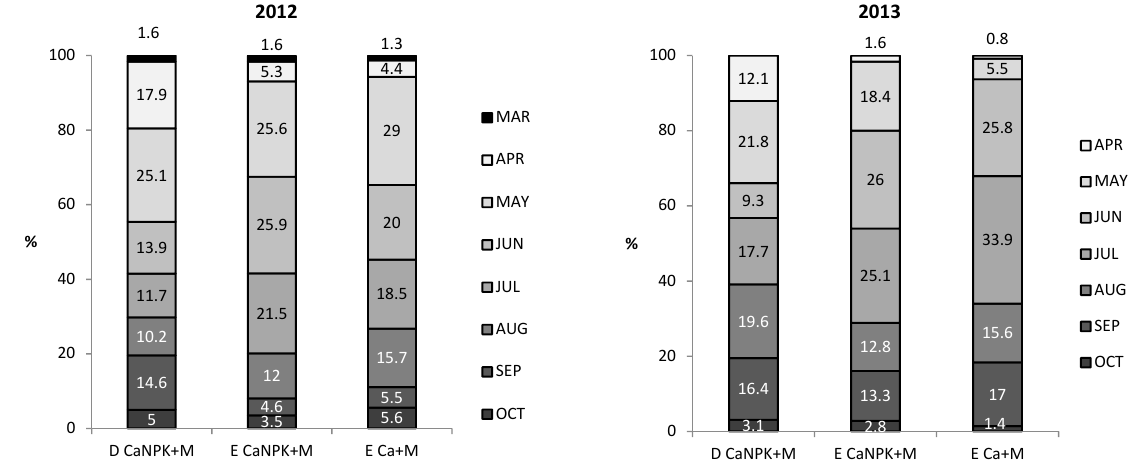
Figure 3. Percent monthly contributions of cumulative CO 2 -C from soil subjected to Ca+M and CaNPK+M treatments under rye monoculture (D) and 5-crop rotation (E) experiments over the measurement period in 2012 and 2013.